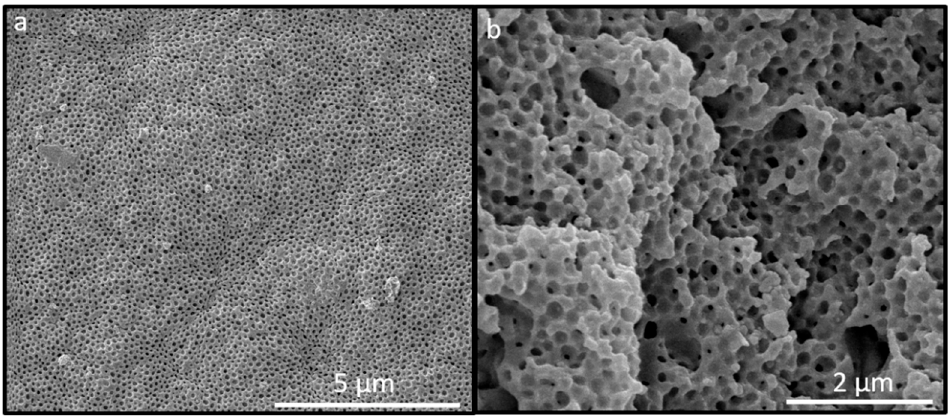
Figure 8. SEM photograph of the topography ( a ) and corresponding cross-section SEM photograph ( b ) of an inverse opal film based on SiO 2 @P(TFEA- co -NFHMA- co - i BuMA) core/interlayer/shell particles after melt-shear organization and subsequent HF etching.